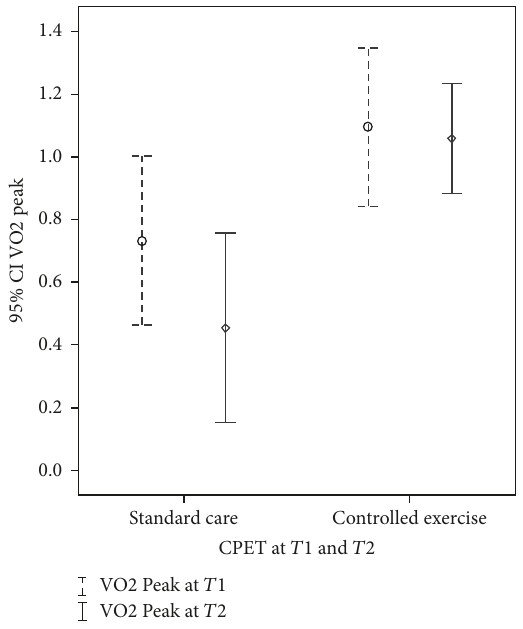
Figure 4: VO2 Peak at T 1 ( 𝑝 = 0.13 , [CI: − 0,78–0,11]) and at T 2 ( 𝑝 = 0.002 , [CI: − 0,96– − 0,25]).